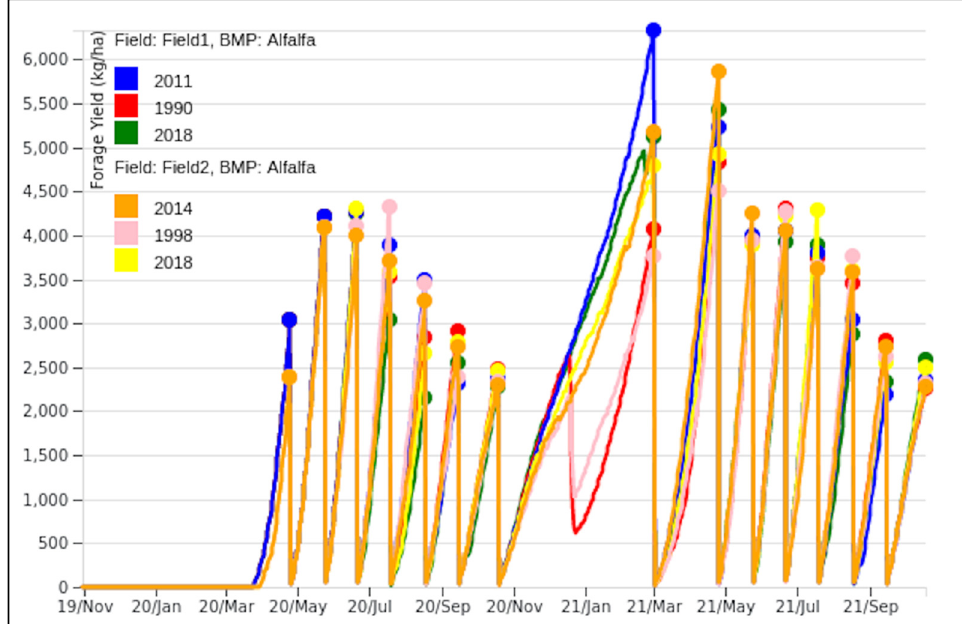
Figure 7. Alfalfa forage Yield (kg/ha) for Field 1 (near Tulare, California) and Field 2 (near Davis, California). Table 8. Summary of the results from simulations (rounded to two decimal digit).